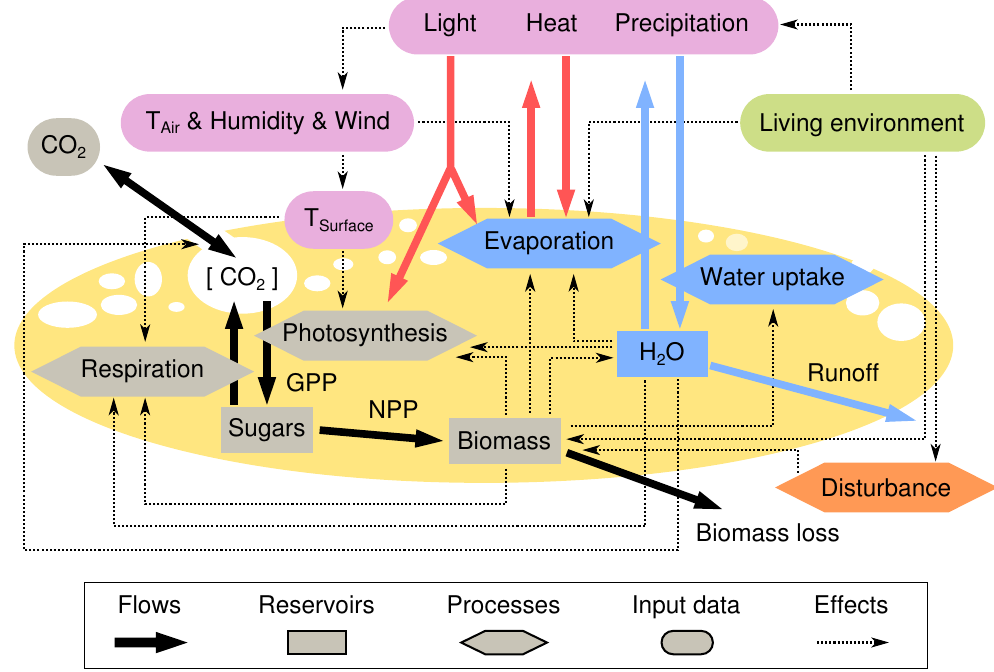
Figure 3: Schematic of the carbon and water relations of a lichen or bryophyte simulated by the model. Dotted arrows illustrate effects of climate forcing, living environment and state variables on physiological processes of a lichen or bryophyte. These processes are associated with exchange flows (solid arrows) of carbon (black), water (blue) and energy (red). respiration, while only the algal/cyanobacterial biomass con- tains Rubisco. In the model, however, lichen respiration is assumed to be controlled by the Rubisco content averaged over the total